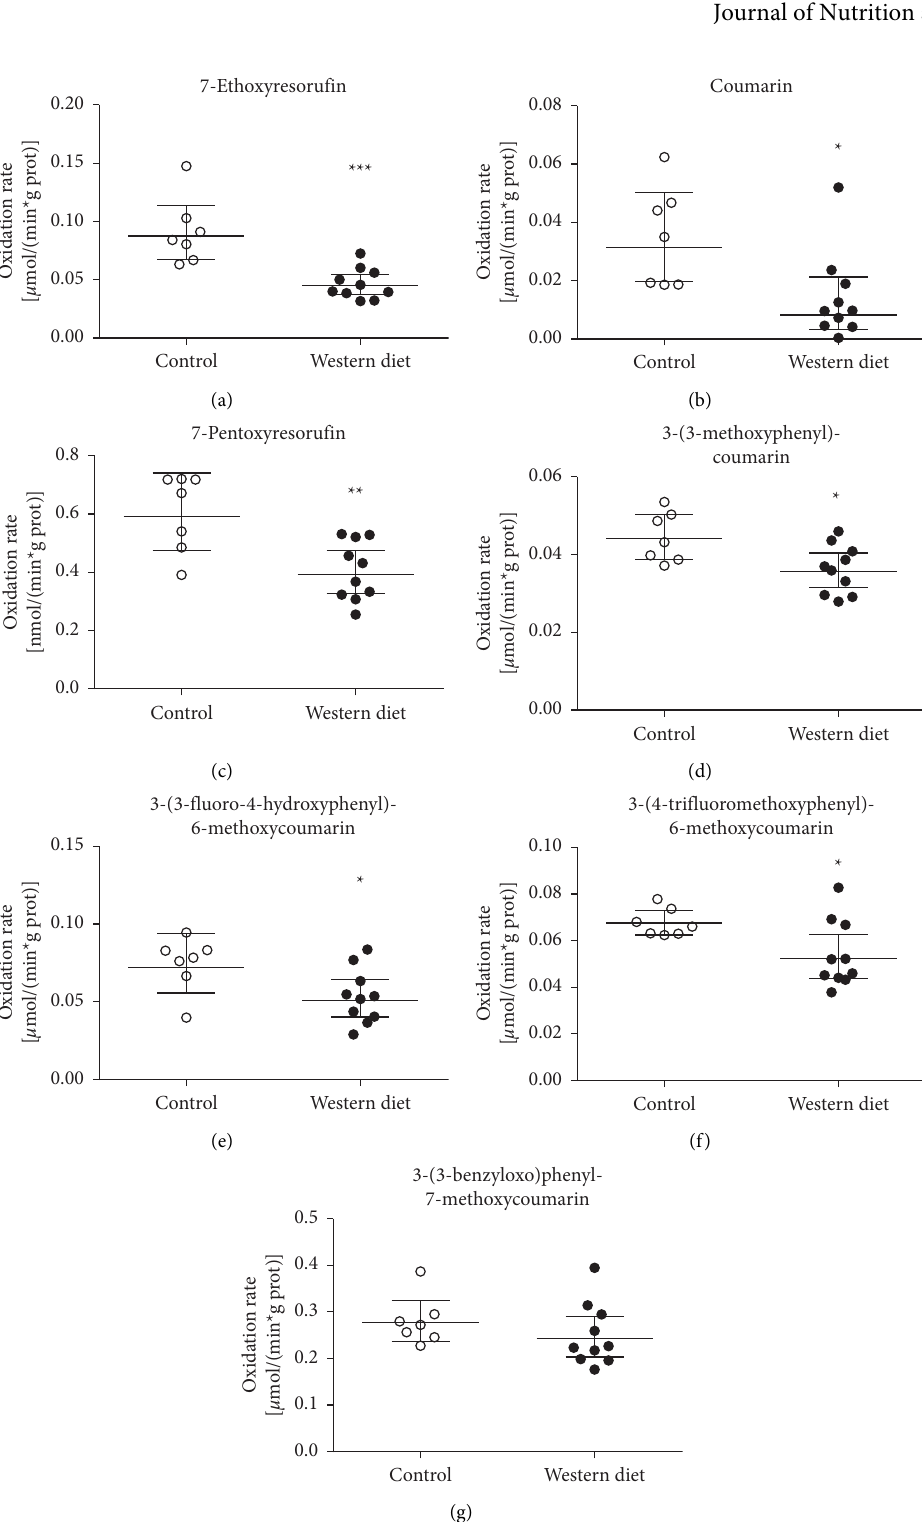
Figure 2: Te efect of consumption of the Western diet (WD) on the probe protein-normalized activities of CYP enzymes in the liver microsomes of male LDLr − / − ApoB 100/100 mice. Te liver microsomes were prepared from the livers of eight months old mice; the animals were fed either with the WD or the chow diet for fve months. CYP-oxidized reactions were determined with the indicated probe substrates: 7-ethoxyresorufn, 7-pentoxyresorufn, coumarin, 3-(4-trifuoromethoxyphenyl)-6-methoxycoumarin, 3-(3-benzyloxo)phenyl-7- methoxycoumarin, 3(3-fuoro-4-hydroxyphenyl)-6-methoxycoumarin, and 3-(3-methoxyphenyl)coumarin. ∗ , p < 0 . 05; ∗∗ , p < 0 . 01; and ∗∗∗ , p < 0 . 001 WD vs. chow diet. Te lines of the groups represent geometrical means with 95% confdence interval: (a) 7-ethoxyresorufn, (b) coumarin, (c) 7-pentoxyresorufn, (d) 3-(3-methoxyphenyl)-coumarin, (e) 3-(3-fuoro-4-hydroxyphenyl)-6-methoxycoumarin, (f) 3- (4-trifuoromethoxyphenyl)-6-methoxycoumarin, and (g)